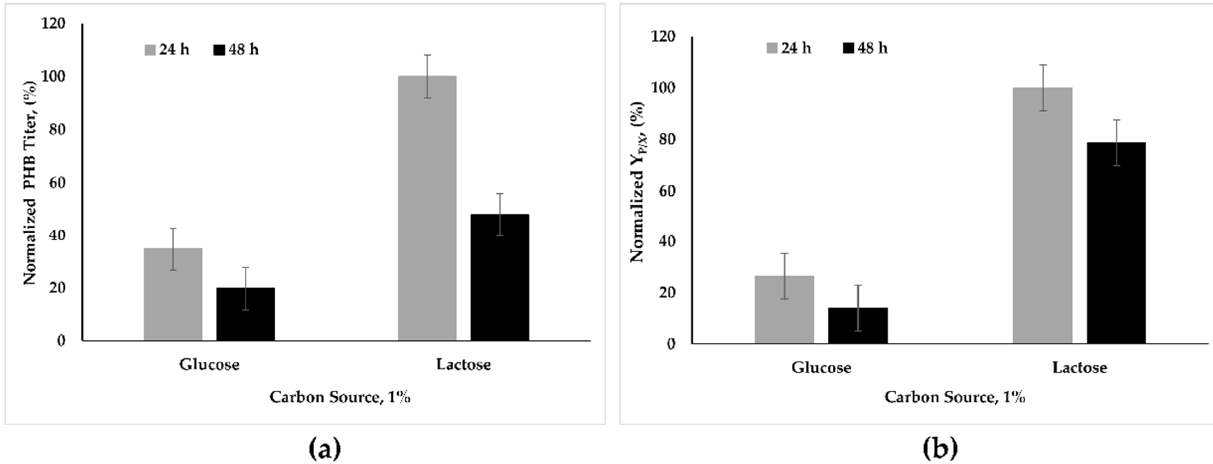
Figure 2. Effect of lactose on PHB synthesis. ( a ) Normalized amount of PHB titer (%). ( b ) Normalized Y P/X (%).